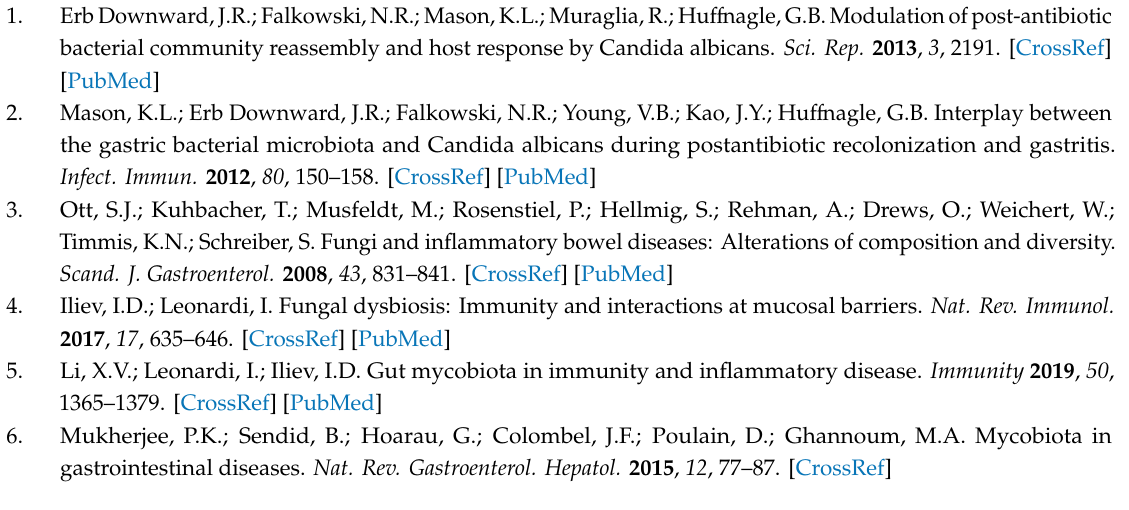
Figure S1: Piglet weight over time. Mean average piglet weight gain by litter (L.1–3) over time (D01–35). Error bars represent ± SEM, Figure S2: Rarefaction curves. Mean observed ASVs in (A) bacterial 16S rRNA and (B) fungal ITS gene sequences in piglet feces over time. Error bars represent ± SEM, Figure S3: Observed ASVs in the bacteriome and mycobiome in piglet feces over time. Observed ASVs for the (A) bacteriome and (B) mycobiome in piglet feces by sample time points (D01–35) and by litter (L.1–3), Figure S4: Taxonomic composition of the bacteriome and mycobiome in piglet feces over time. Mean percent relative abundances by litter (L.1–3) at the phylum level for the most abundant members of the (A) bacteriome and (B) mycobiome over time (D01–35). Sows (Sows), adult feces (A–F), and nursery feed (Feed) are included for comparison, Figure S5: NMDS plots displaying taxonomical di ff erences between pre- and post-wean piglet fecal microbiota. The top 50 most abundant families in the (A) bacteriome and (B) mycobiome were fitted against the ordination plot using the envfit function (R-package vegan). Ordination of pre-wean (D01–21) and post-wean (D24–35) samples, represented by the colored polygons, is based on Bray–Curtis dissimilarity of ASV composition. Taxon vectors are indicated by arrows, with length proportional to the correlation variable between the taxon and NMDS ordination. Only significant taxon families are shown ( p < 0.05), Table S1: Piglet Diet. Percent composition of piglet diet, Table S2: The 16S rRNA and ITS gene sequencing results. Number of bacterial and fungal samples and sequences analyzed in this study. Sample types are piglet feces (D01–35), sow feces (Sows), adult feces (pens. A–F), and nursery feed (Feed), Table S3: PERMANOVA results. PERMANOVA results testing for the main e ff ect of sample time point (D01–35) on the piglet fecal (A) bacteriome and (B) mycobiome. Tests were conducted using the strata option, which allows for blocking by piglet, Table S4: Dispersion results. Dispersion testing and pairwise comparisons, Table S5: Di ff erentially abundant genera. Di ff erentially abundant genera in pre- vs. post-wean piglet feces in the (A) bacteriome and (B) mycobiome. FDR-corrected p -values were calculated using a linear mixed-e ff ect regression model controlling for individual piglet and litter. Only significant genera are shown ( p <